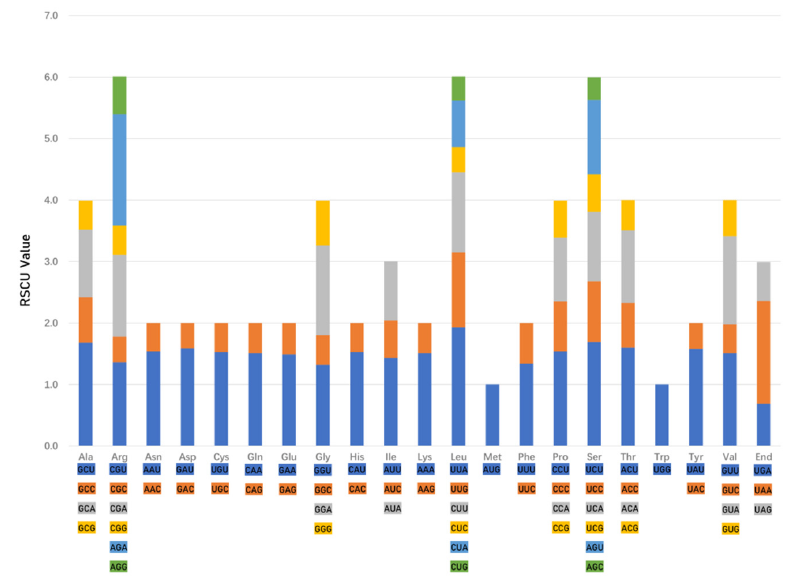
Figure 5. Codon content of 20 amino acid and stop codon in 53 coding genes of the Chamaesium plastid genome. The color of the histogram corresponds to the color of codons.